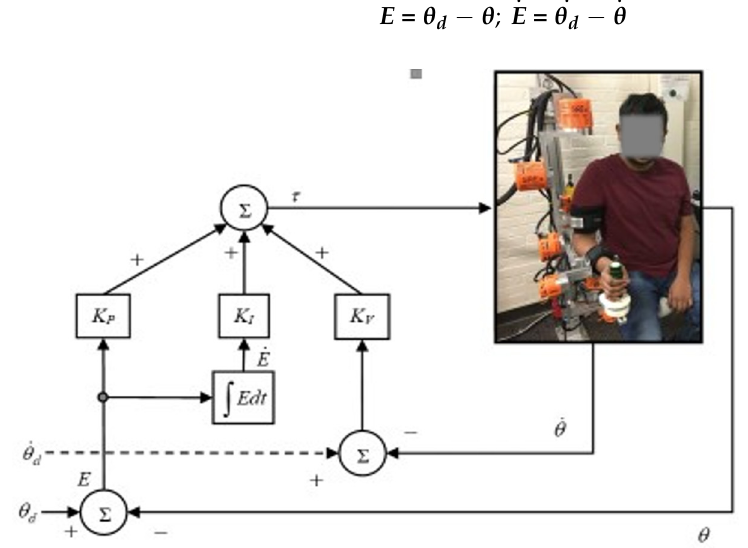
Figure 3. Schematic diagram of PID control.